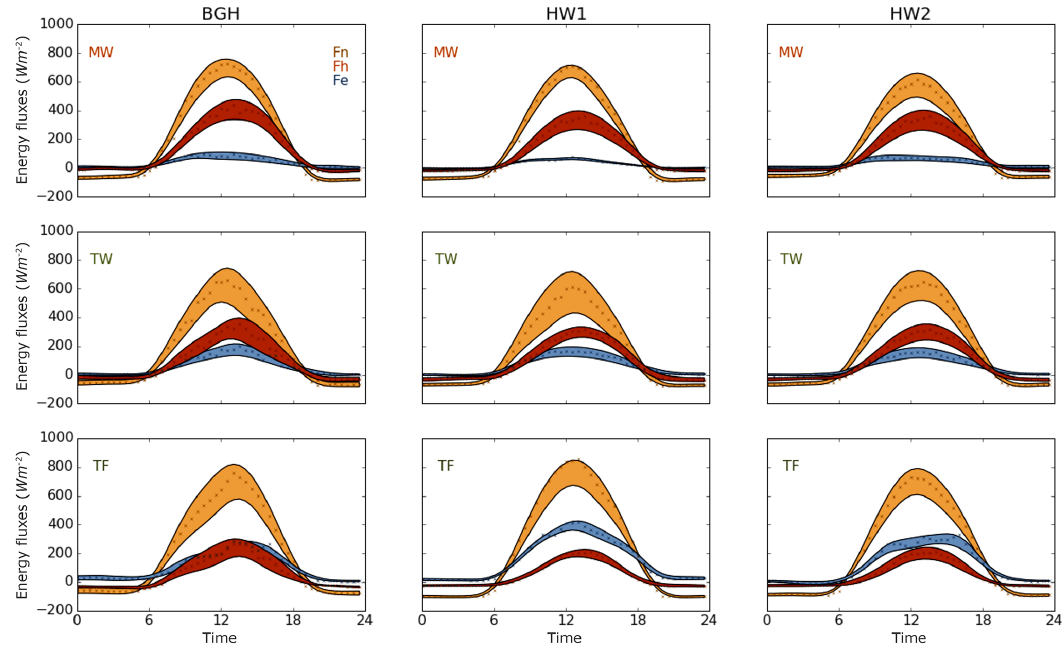
Figure 5. Diurnal course of net radiation (Fn, light amber), sensible (Fh, red) and latent (Fe, blue) heat at the Mediterranean woodlands (MW, top row), the temperate woodlands (TW, middle row) and the temperate forest (TF, lowest row) for the background period BGH (2–6 January 2014), and the first and second period of the heat wave (HW1, 1–9 January 2013; HW2, 10–18 January 2013). Filled areas indicate the range of smoothed ± 1 standard deviation, average mean values are indicated by